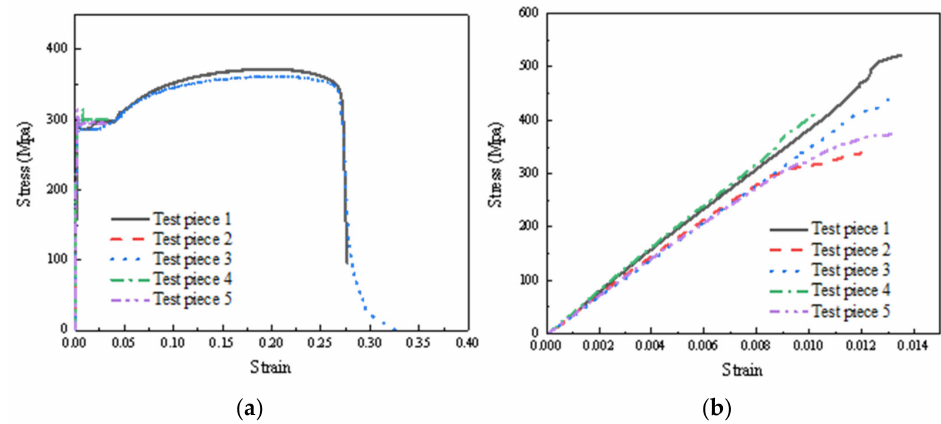
Figure 5. Stress–strain relationship curve. ( a ) Cold-formed steel. ( b ) Fireproof phenolic board. Table 2. Measured material